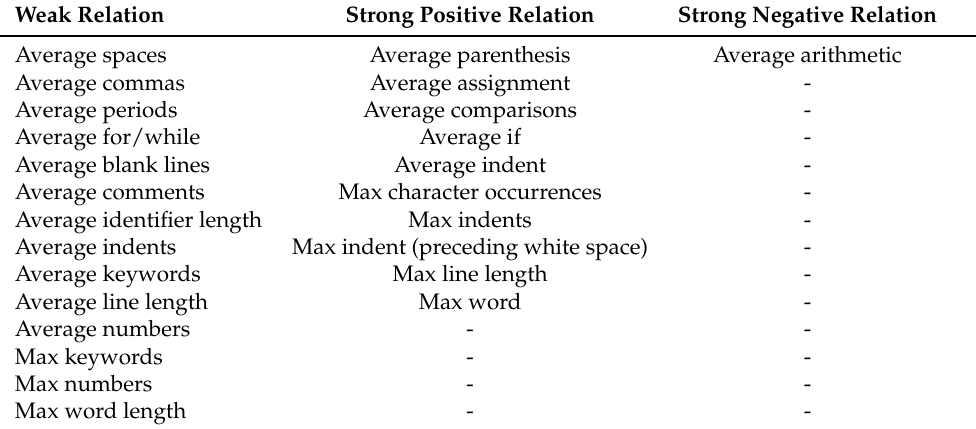
Table 11. LOC and readability metrics relation.